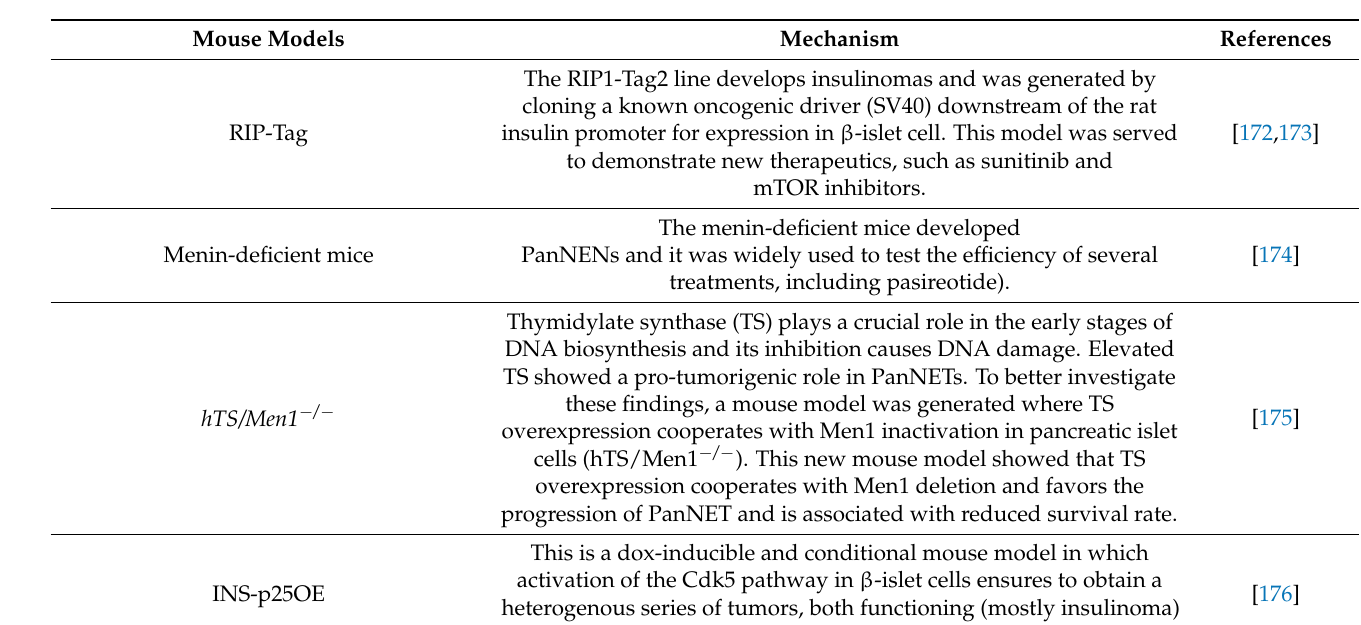
Table 3. The most common and new mice models to study PanNENs. TS: thymidylate synthase; Pc2: prohormone